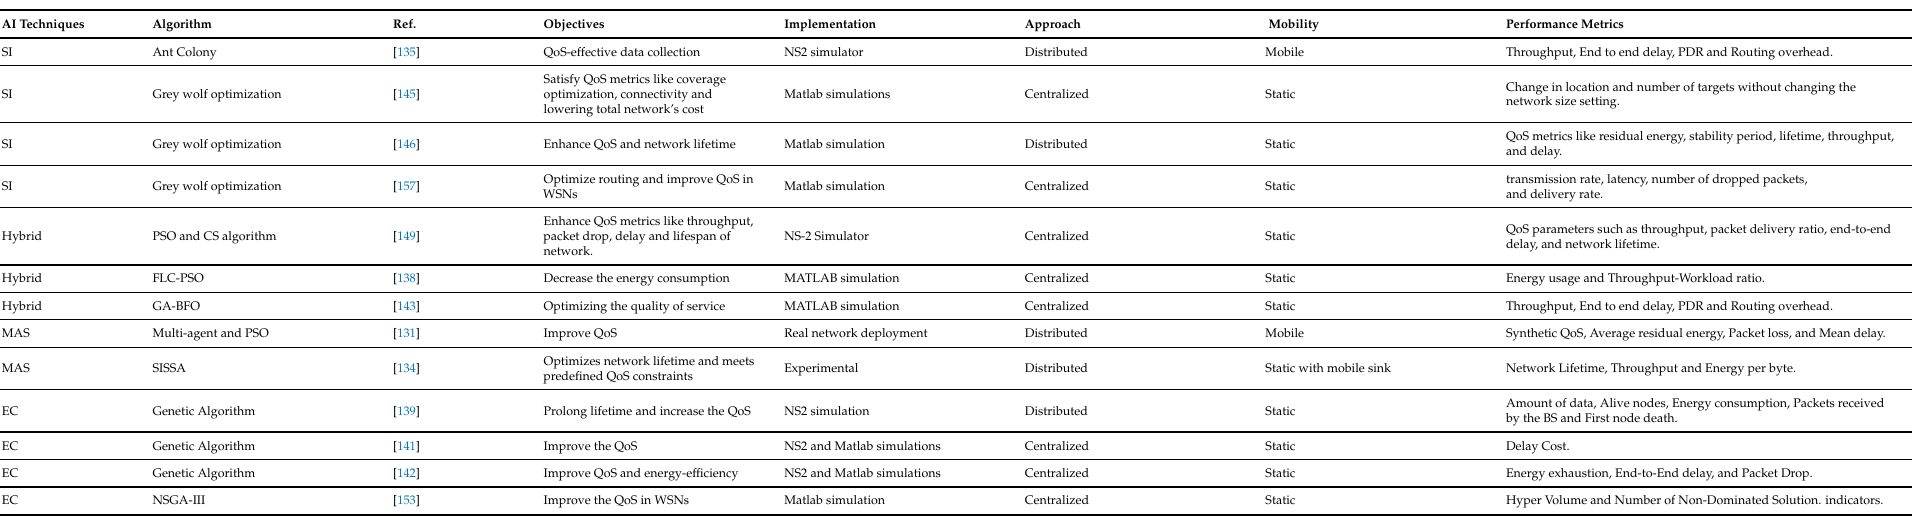
Table 6. Summary of AI-based solutions to QoS problem surveyed in Section